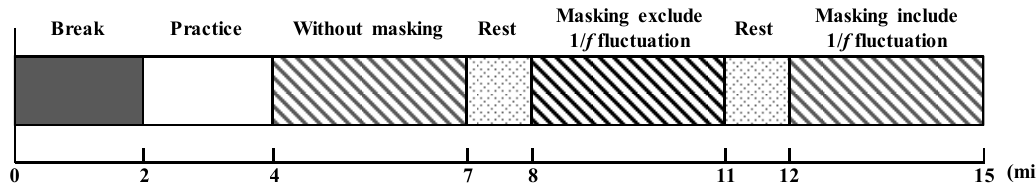
Figure 5. Experimental situation by using driving simulator.